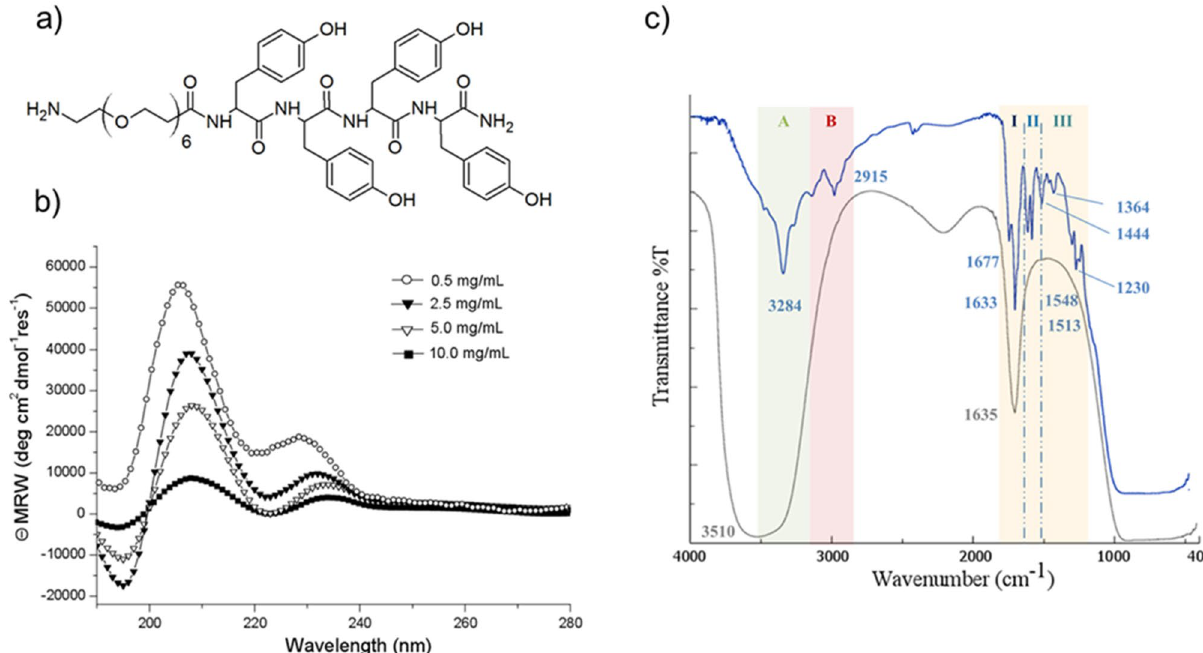
Figure 1. ( a ) Schematic representation of PEG6-Y4. ( b ) CD spectra profiles of PEG6-Y4 recorded in water in 190–280 nm range at several concentrations. ( c ) FTIR spectra of PEG6-Y4 in water solution at a concentration of 2.0 mg/mL (grey line) and at solid state on the sample obtained by drying the sample sin solution (blue